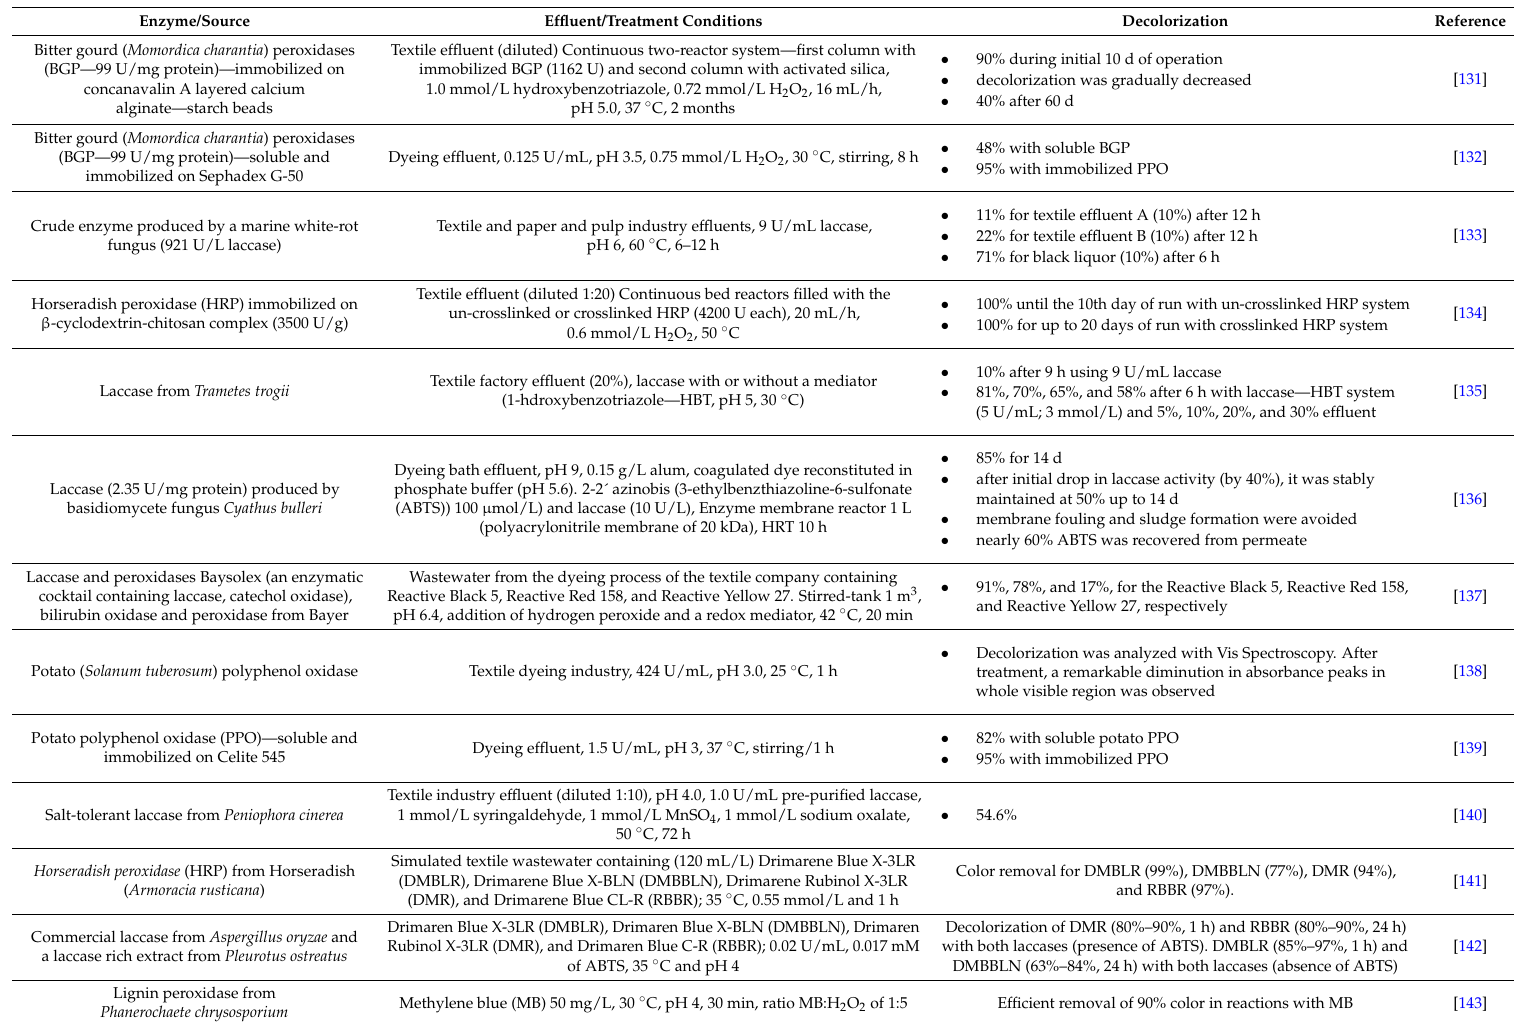
Table 3. Color removal from industrial effluents by biocatalysts of different biological